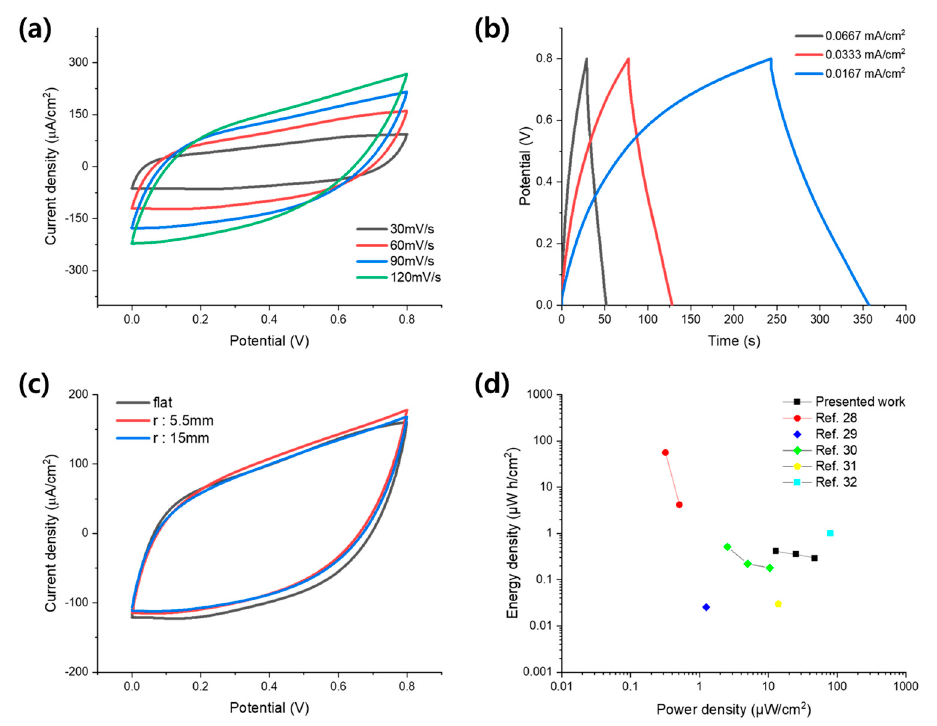
Figure 6. Electrochemical performances of the supercapacitor made up with a pair of the Ag/Au/MnO 2 core − shell NW electrodes. ( a ) CV curves of a supercapacitor based on the Ag/Au/MnO 2 (2 min) core–shell NW electrodes at different voltage scan rates. ( b ) Charge/discharge curves at different current densities. ( c ) CV curves at various bending radii with a scan rate of 60 mV/s. ( d ) Ragone plot considering the recently reported flexible supercapacitors [28–32].